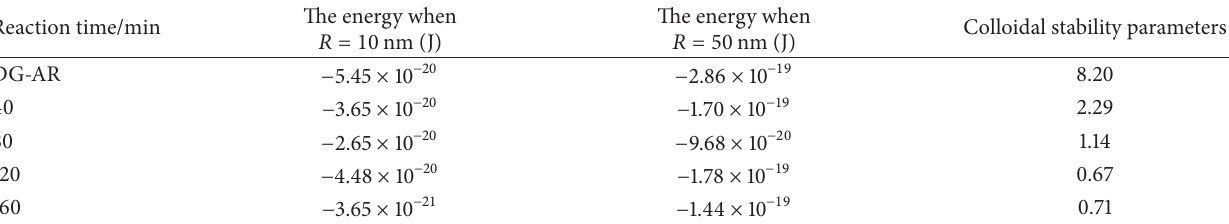
Table 6: The attractive energy between colloids of DG-AR for model #7.